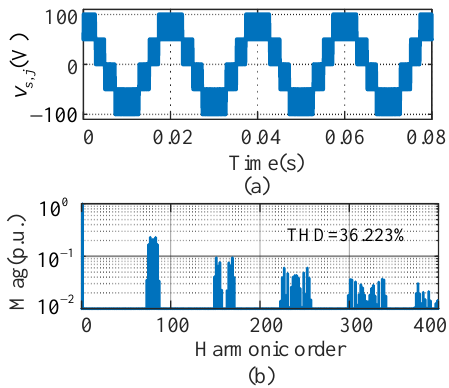
Figure 12. Theoretical output voltage of PSC4. ( a ) Waveform of equivalent output-phase voltage; ( b ) FFT analysis.